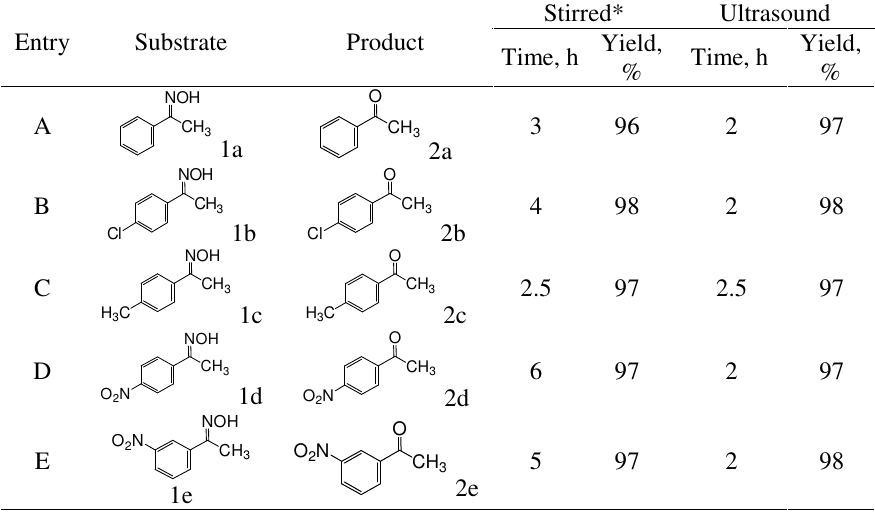
Table 2. Oxidative cleavage of carbon-nitrogen double bonds by using ACC/M K10 with or without ultrasound irradiation at room